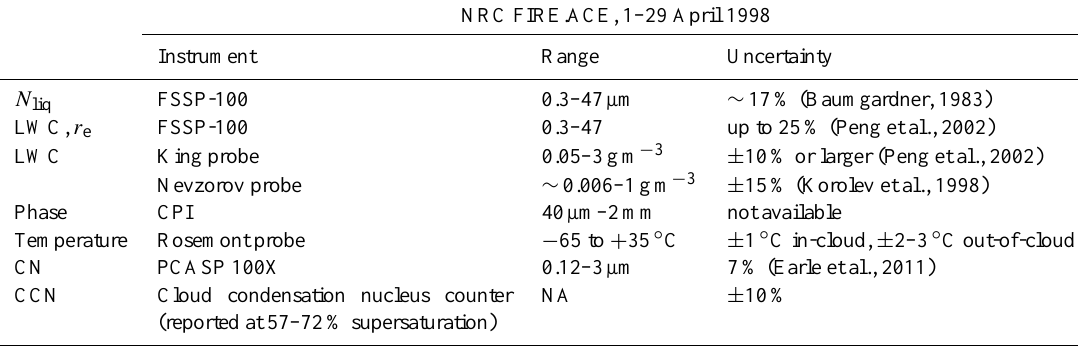
Table 3. Instrumentation used in this study from the NRC FIRE.ACE data set. Data were collected at 1s resolution.